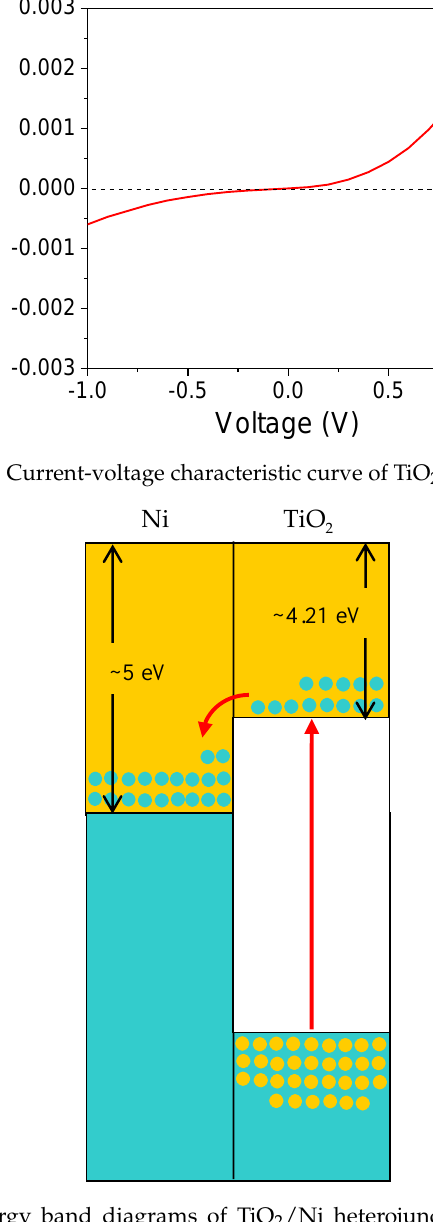
Figure 4. Schematic energy band diagrams of TiO 2 /Ni heterojunction with electron-hole pairs separation mechanism after UV light irradiation.